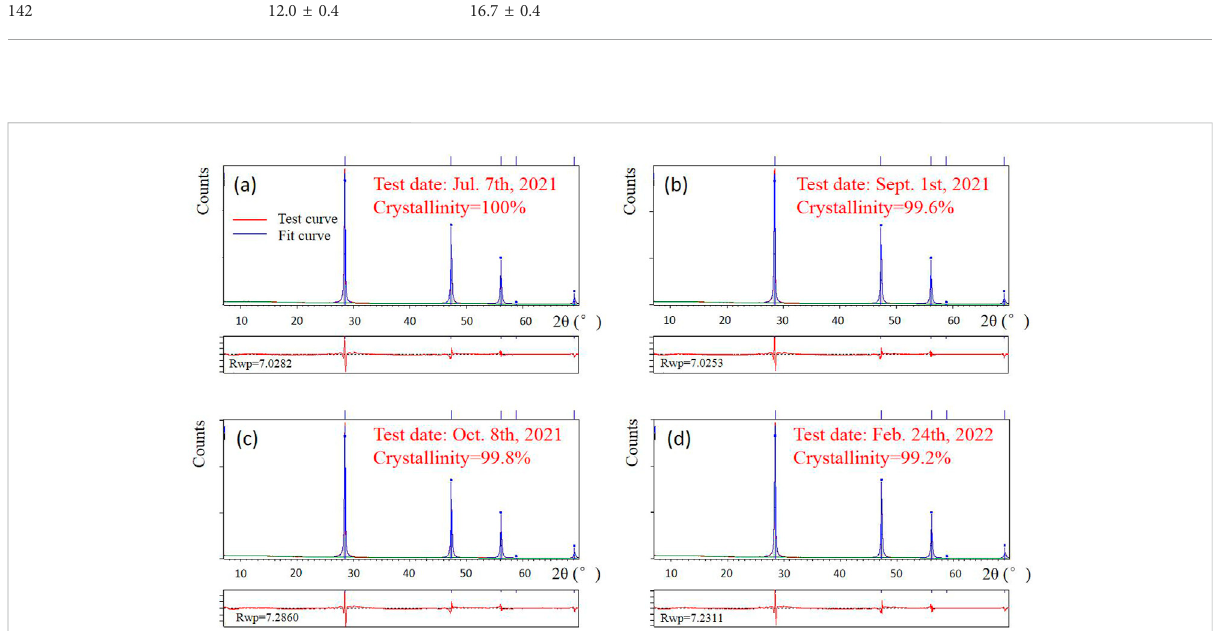
FIGURE 1 Crystallinity analysis of monocrystalline silicon using the external standard method. (A – D) in different test date.